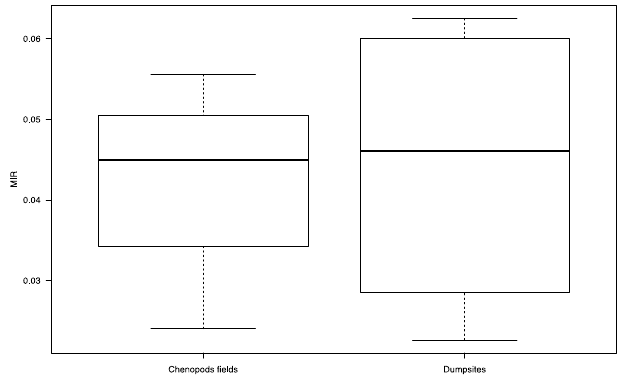
Figure 7. The minimum infection rates of P. papatasi with L. major in dumpsites ( n = 4) and chenopod fields ( n = 4). (The thick black line represents the median. Lower and upper lines represent the first and third quartile, respectively. Whiskers show the minimum and maximum values.